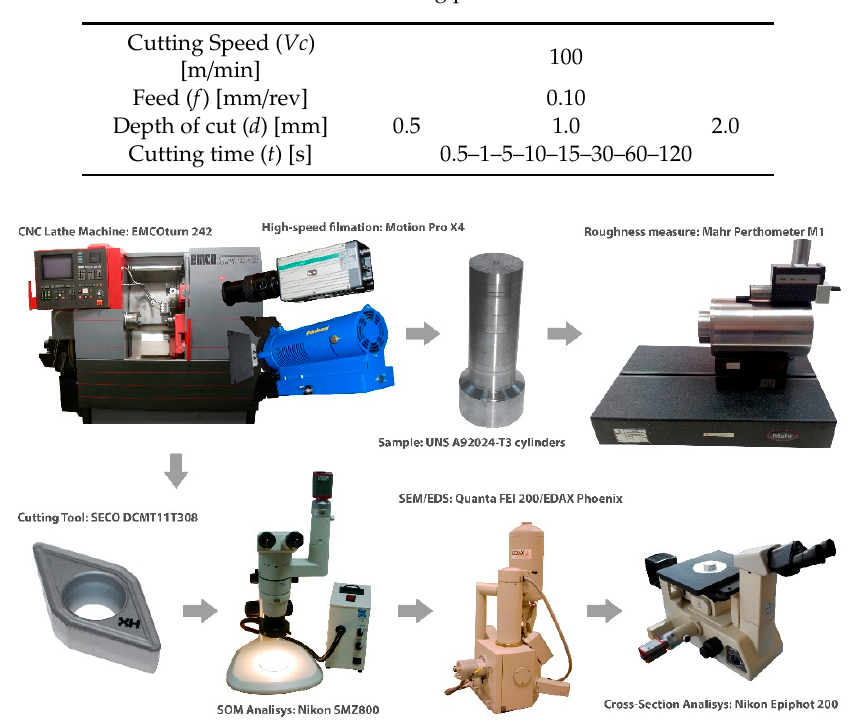
Figure 1. Experimental procedure and equipment. Abbreviations: SEM = scanning electron microscopy; EDS = energy dispersive spectroscopy; SOM = stereoscopic optical microscopy.